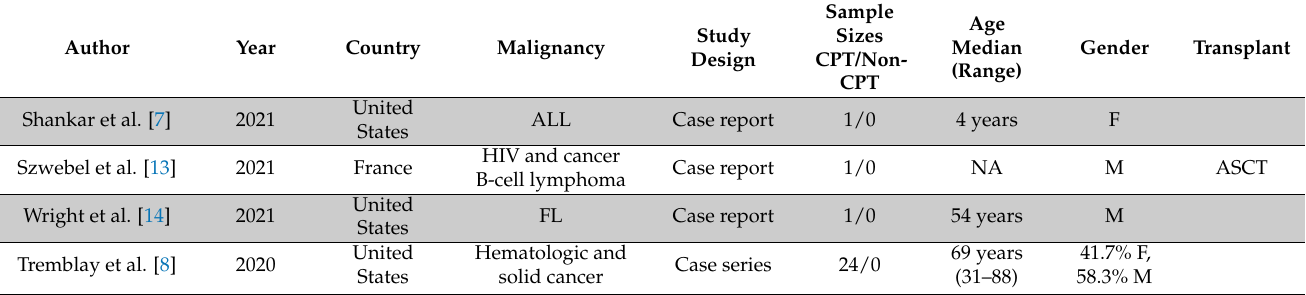
Table 2. Summary of included studies on CPT for COVID-19 patients with hematological